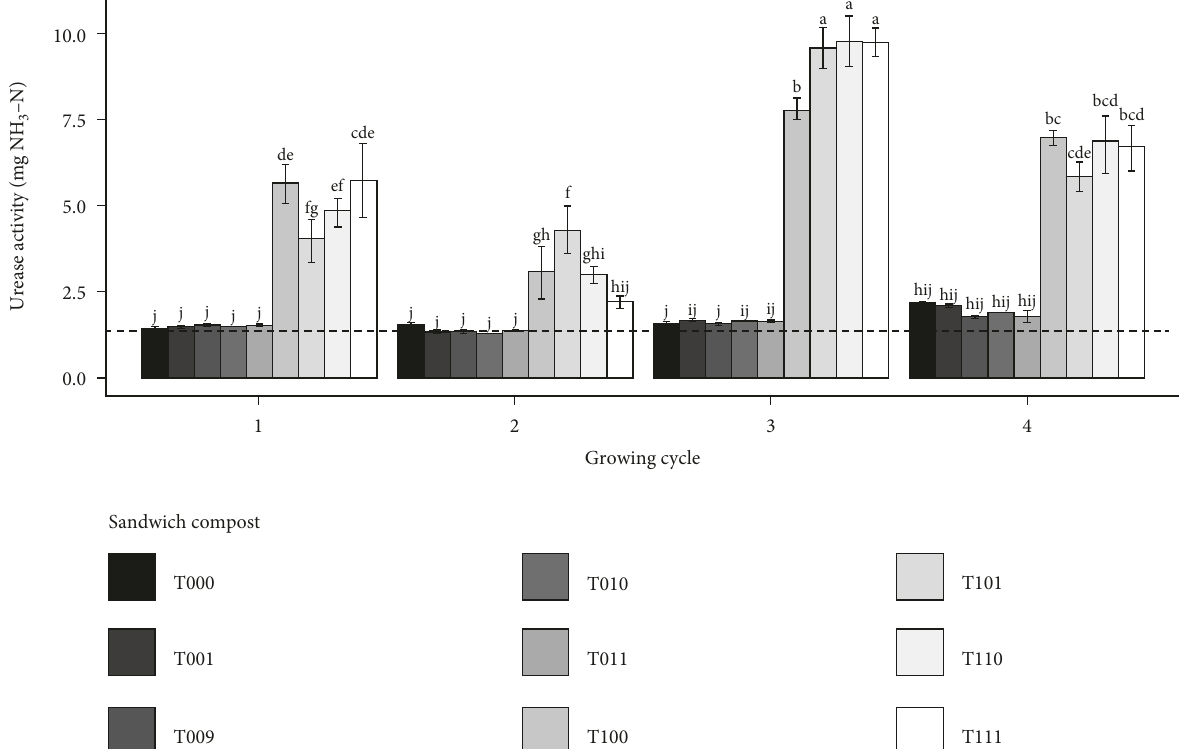
Figure 6: Effect of the growing cycle and Sandwich compost amendments on urease activity (mg NH different letters is significantly different at P < 0 . 05 when using DMRT. The dotted line is referred to as the original soil urease activity (1.33mg NH 3